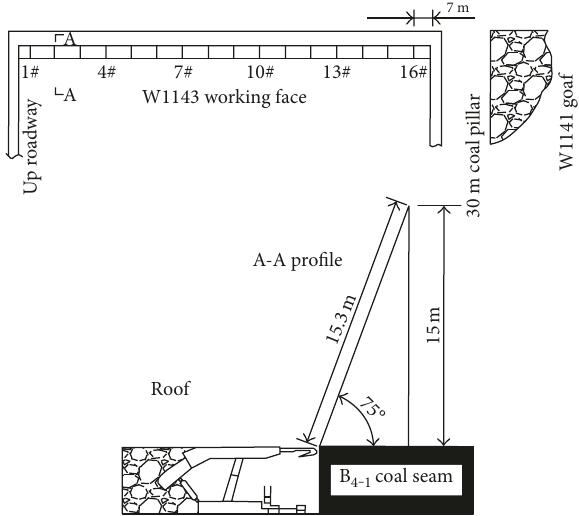
Figure 16: Borehole layout of roof breaking blasting. (a) Planar graph. (b)